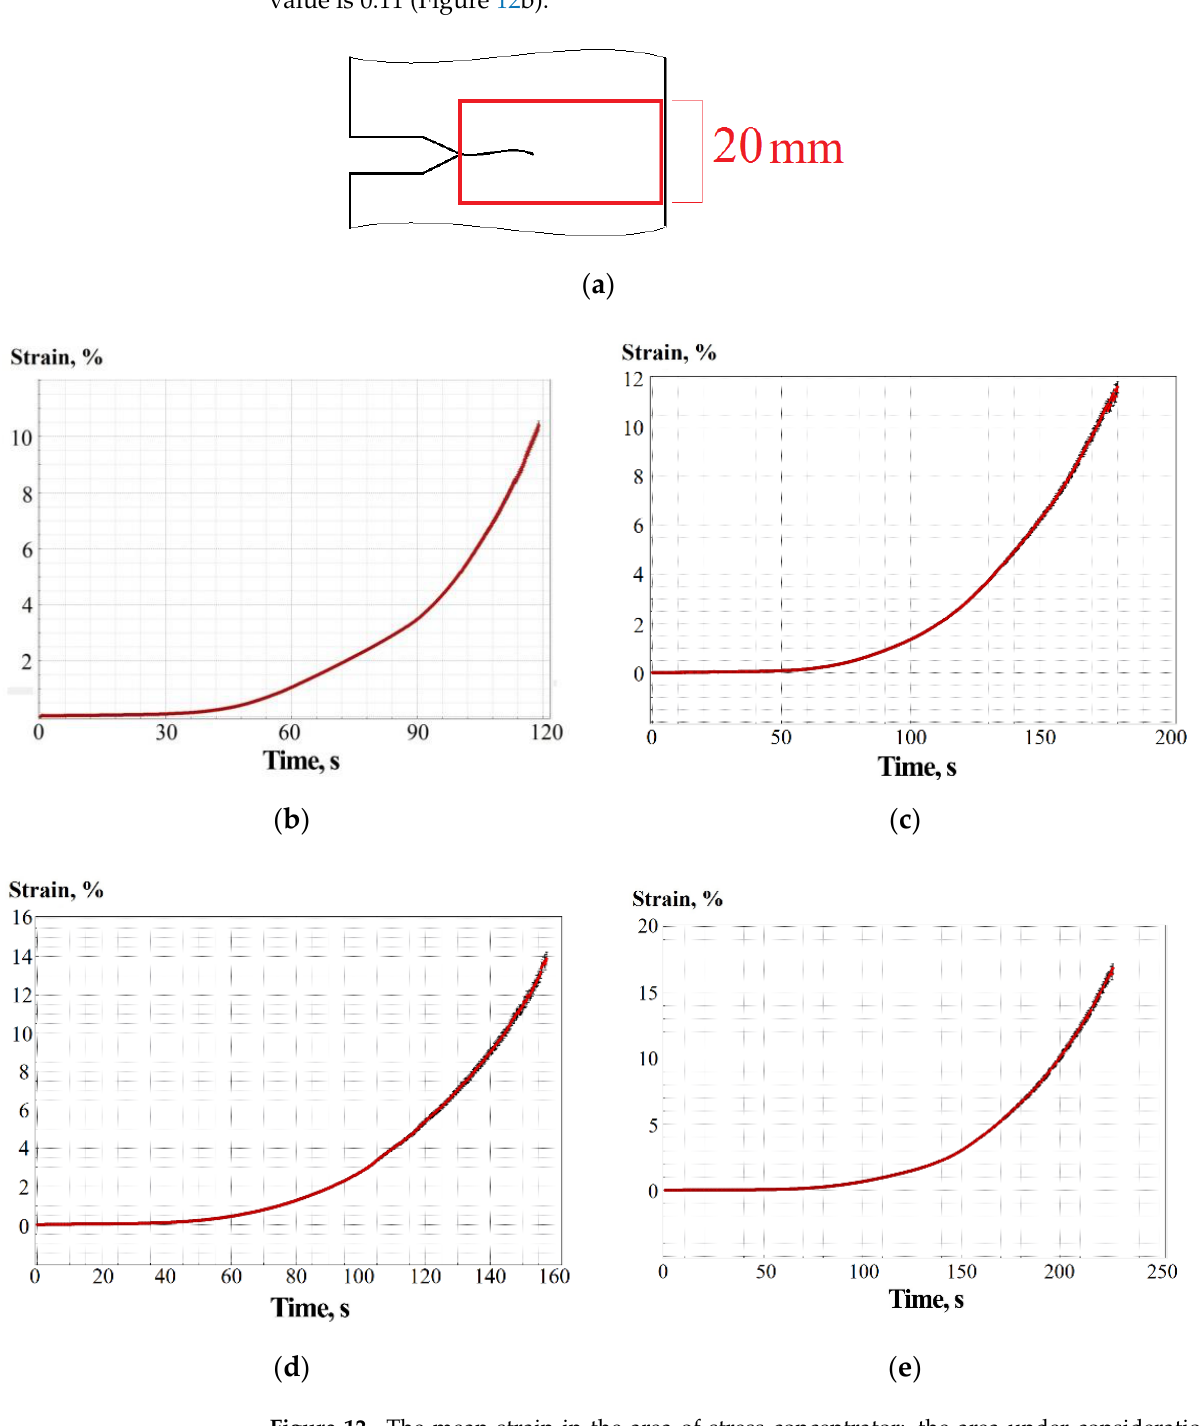
Figure 12. The mean strain in the area of stress concentrator: the area under consideration ( a ); specimen of 1 mm thick ( b ); 3 mm thick ( c ); 5 mm thick ( d ) and 6 mm thick ( e ).